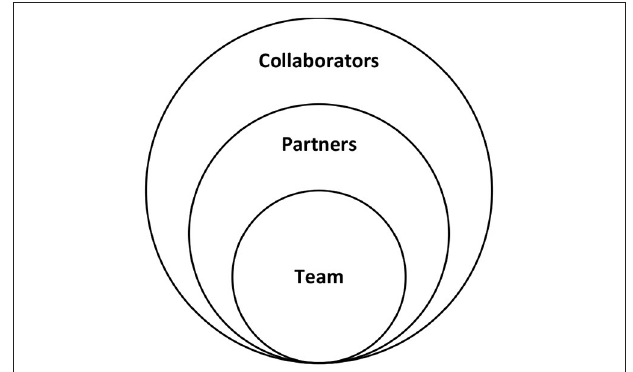
FIGURE 2 | Cross-disciplinary composition of